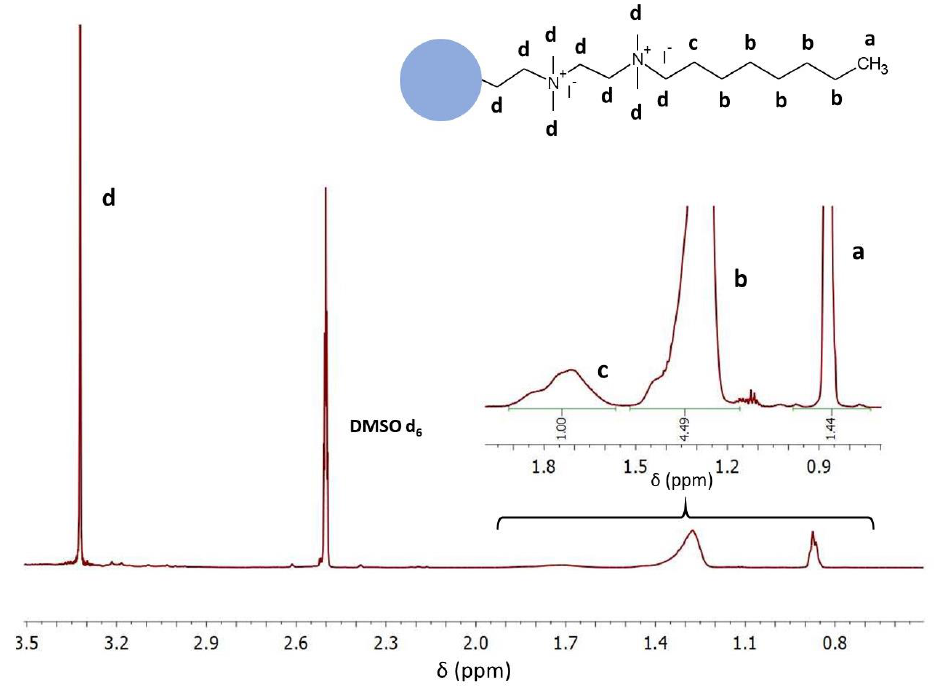
Figure 4. The 1 H NMR spectrum of QA-PEI-NPs.